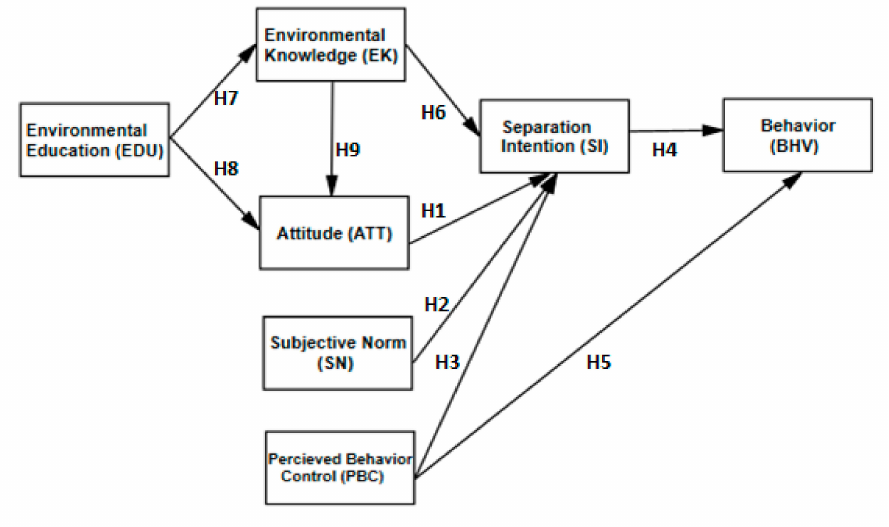
Figure 1. The proposed research